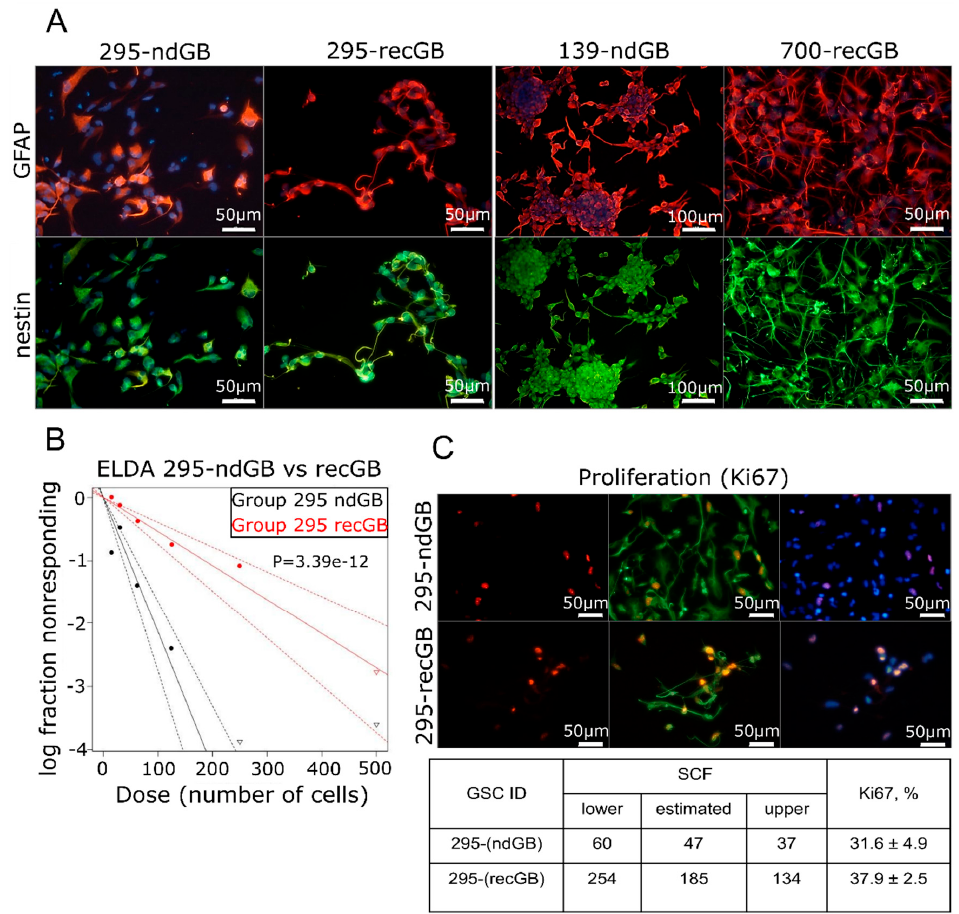
Figure 4. Assessments of stemness attributes and proliferation in GSCs. ( A ) Expression of the neural stem cell / neural progenitor marker nestin (green) and astrocytic marker GFAP (red) in GSCs isolated from ndGBs (samples 295-ndGB and 139-ndGB) or recGB (samples 295-recGB and 700-recGB). Samples 295-ndGB and 295-recGB represent isogenic GSCs derived from the same patient at the time of initial diagnosis or at recurrence, respectively. ( B , C ) Quantitative analyses of the self-renewal activity by ELDA (B, representative image) and proliferation rate by assessing Ki67 expressing cells using immunofluorescence staining (C, representative image). The table summarizes quantification results of ELDA and Ki67. “SCF”, stem cell frequency; “lower” and “upper”, confidence intervals for 1 / (stem cell frequency). 295-ndGB and 295-recGB correspond to isogenic GSCs derived from the same patient at the time of initial diagnosis or at recurrence, respectively.